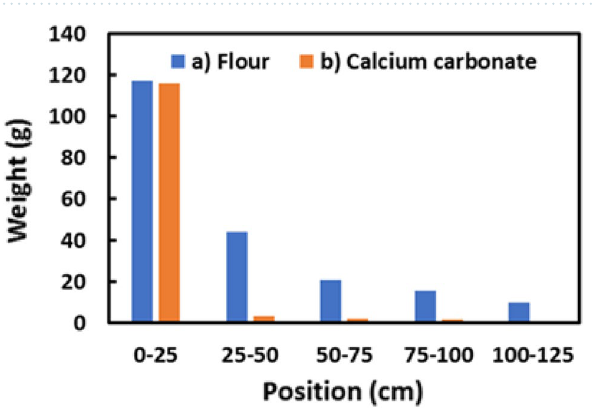
Figure 4. Dust flow experiment. The dust is released and flown through the wind tunnel by the wind. The dust flow is monitored by LCDL at 6.5 m from the wind tunnel, and the wind speed in the wind tunnel is simultaneously measured by an anemometer. The released dust is collected in the five trays placed inside the wind tunnel.